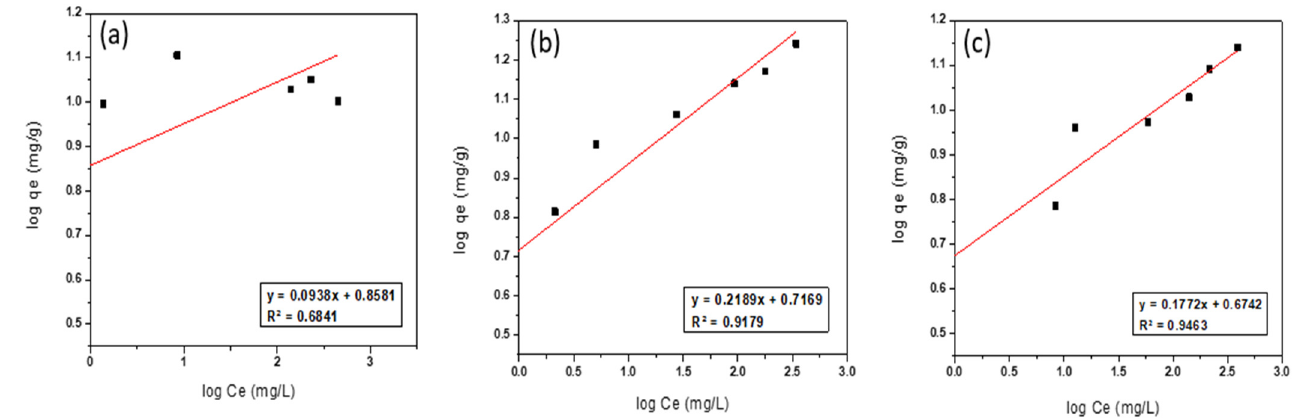
Figure 13. Freundlich isotherm model of thorium adsorption onto ( a ) NZ, ( b ) PZ, and ( c ) SZ.